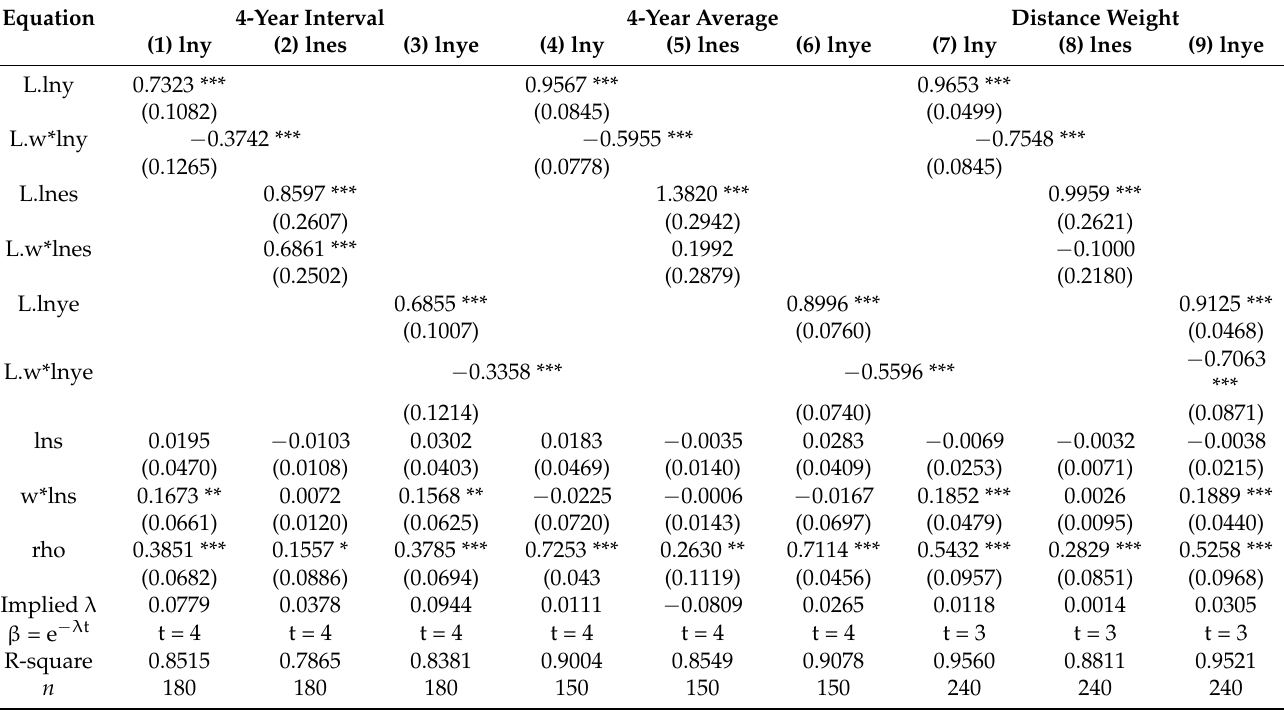
Table 8. Robustness Test Results Based on SDM